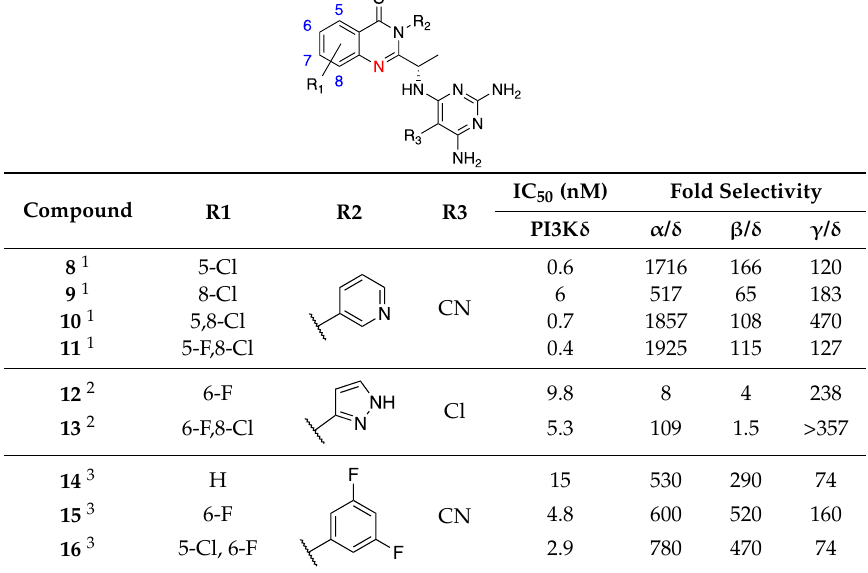
Figure 3. Modifications of the specificity pocket binding moiety. ( a ) Idelalisib ( 3 ) bound to p110 δ (PDB ID 4EX0). Substituents at the 5-position of 7 are predicted to interact with either δ Lys712 or δ Gln748. ( b ) Structure of idelalisib ( 3 ) and umbralisib ( 4 ). ( c ) Structures of 5 – 7. Table 2. Effects of modifications around a quinoxalinone core on potency and selectivity. Substitutions modify the basicity of N1, which is colored in red.